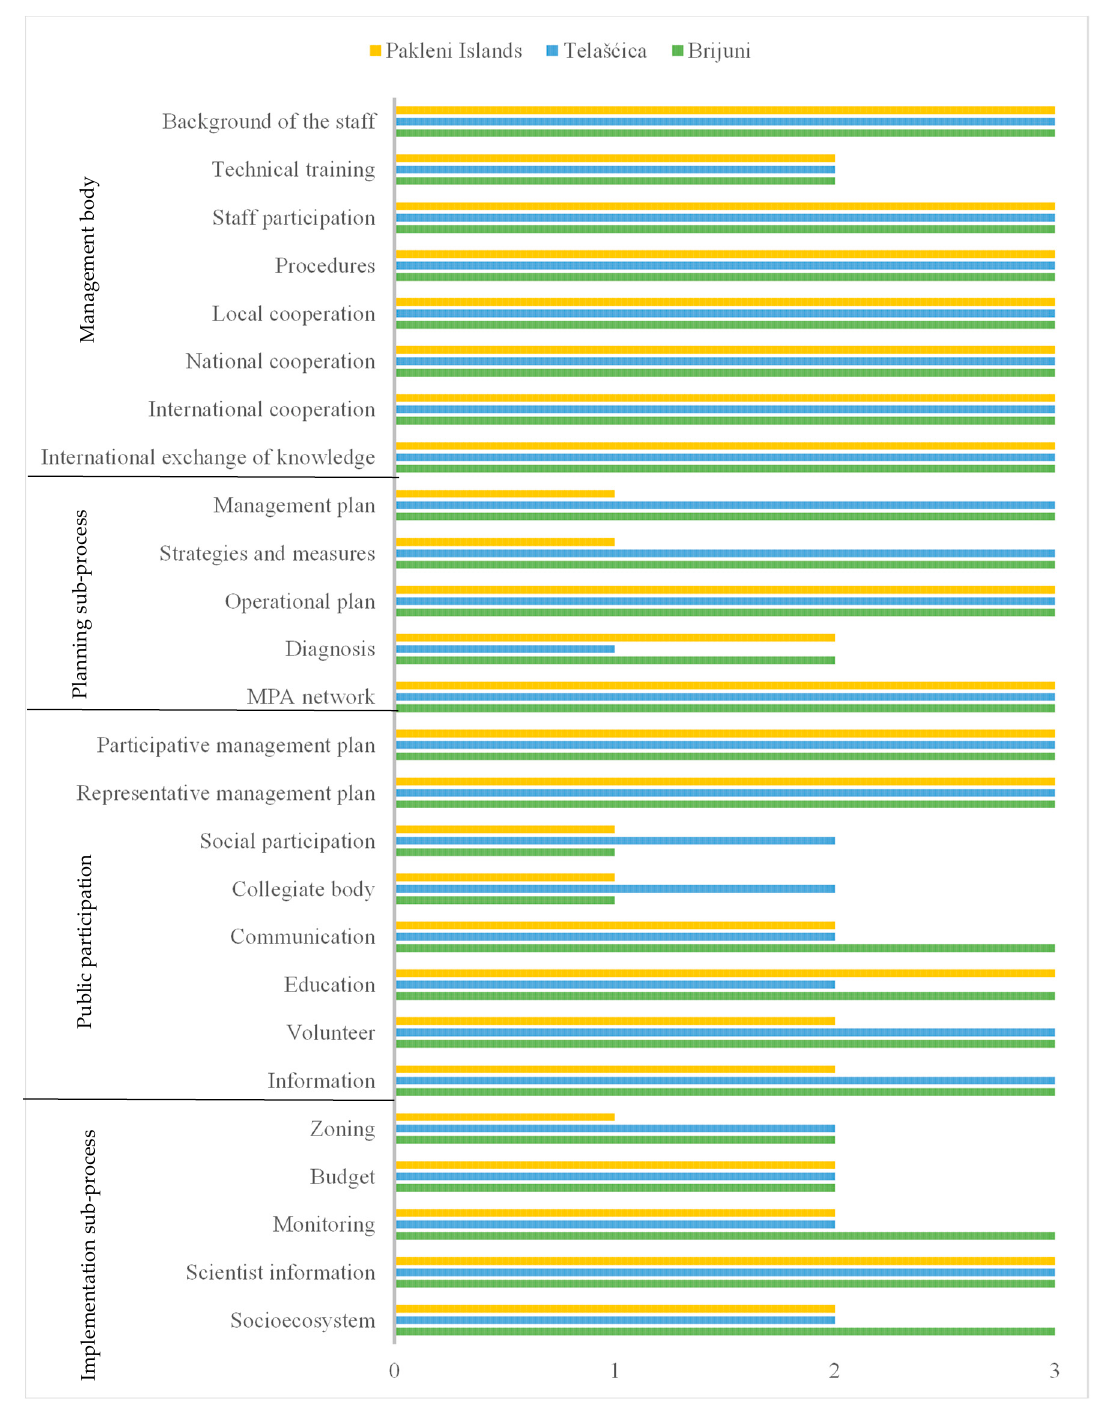
Figure 3. Assessment of indicators.